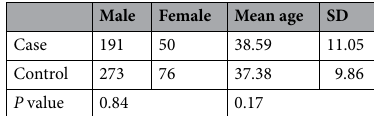
Table 2. Demographic